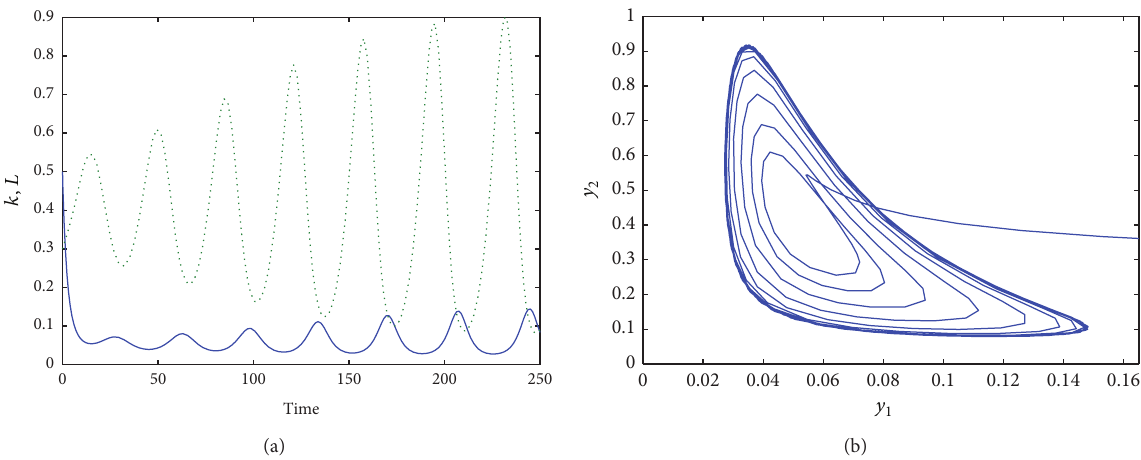
Figure 1: The time evolution of the functions 𝑘(𝑡) (dotted line) and 𝐿(𝑡) for 𝛼 = 0.8 , 𝑠 = 0.5 , 𝑎 = 0.2 , 𝑏 = 0.5 , 𝛿 = 0.9 , and 𝜏 = 9 (a). The phase space of 𝐿(𝑡) versus 𝑘(𝑡) for 𝑡 ∈ [0, 500] (b).